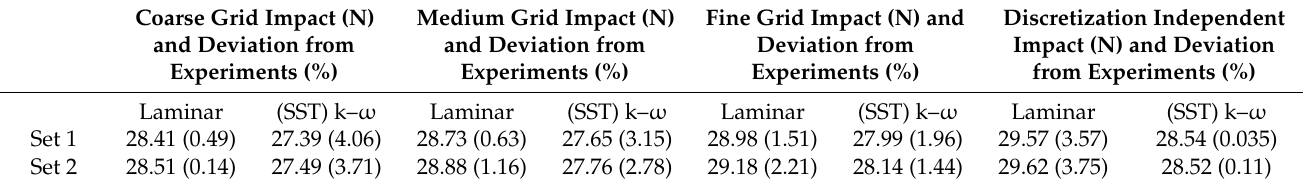
Figure 7. Time step refinement ratio versus grid spacing refinement ratio ( a ) and grid spacing and time step independent longitudinal impact load versus the arithmetic mean of the x ij and y ij ( b ) based on the turbulent flow model. The data were from ref. [11]. Table 5. Discretization-independent predictions and impact loads from the coarse, medium, and fine grids and their deviations from experimental measurements (in